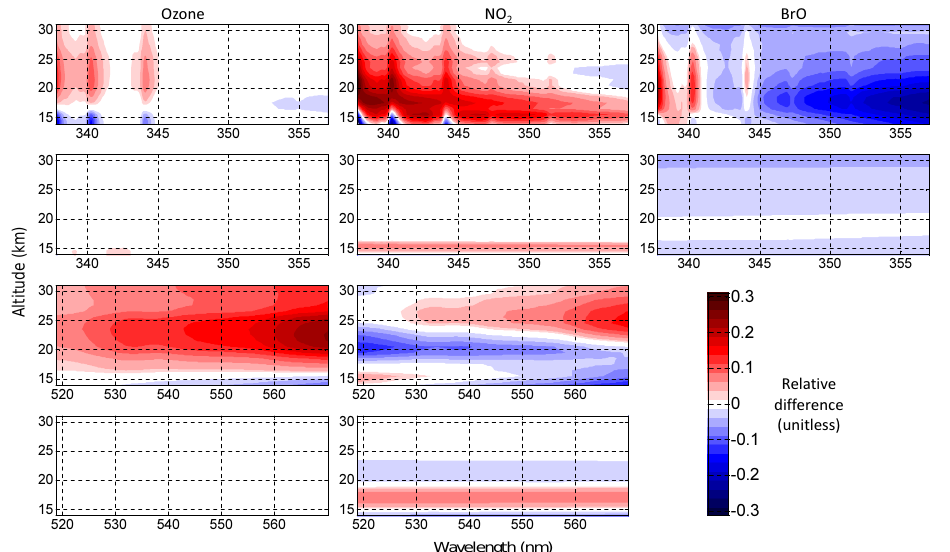
Figure 14. From left: ozone, NO 2 , and BrO: relative differences between the trace gas profiles retrieved at different wavelengths by different approaches with respect to the true profile smoothed by averaging kernels. Rows from top to bottom: retrieval in the UV by the linear approach (with effective light paths calculated for the a priori), retrieval in the UV by the iterative approach, retrieval in the visible by the linear approach (with effective light paths calculated for the a priori), and retrieval in the visible by the iterative